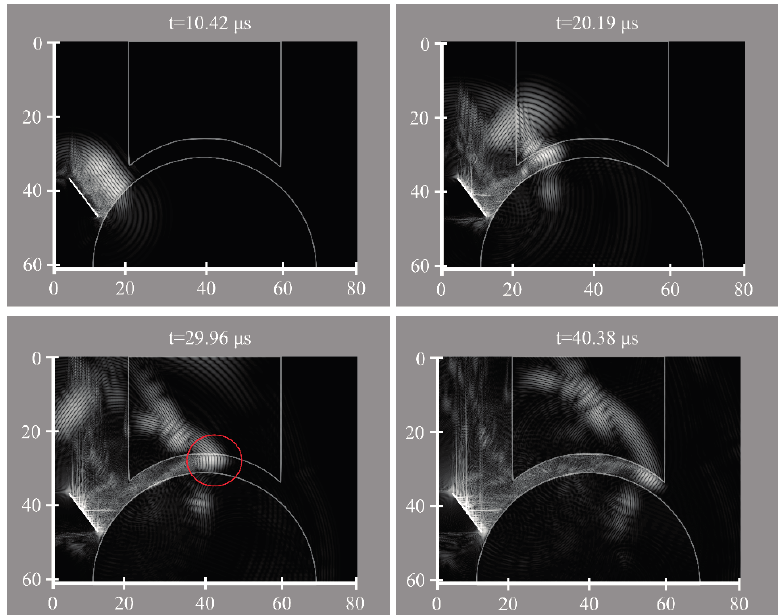
Figure 10. Simulated ultrasound pulse at t = 10.42 µs, 20.19 µs, 29.96 µs and 40.38 µs. The white bar is the transducer acting as transmitter. Red circle is used to emphasize US pulse guided along the tibia